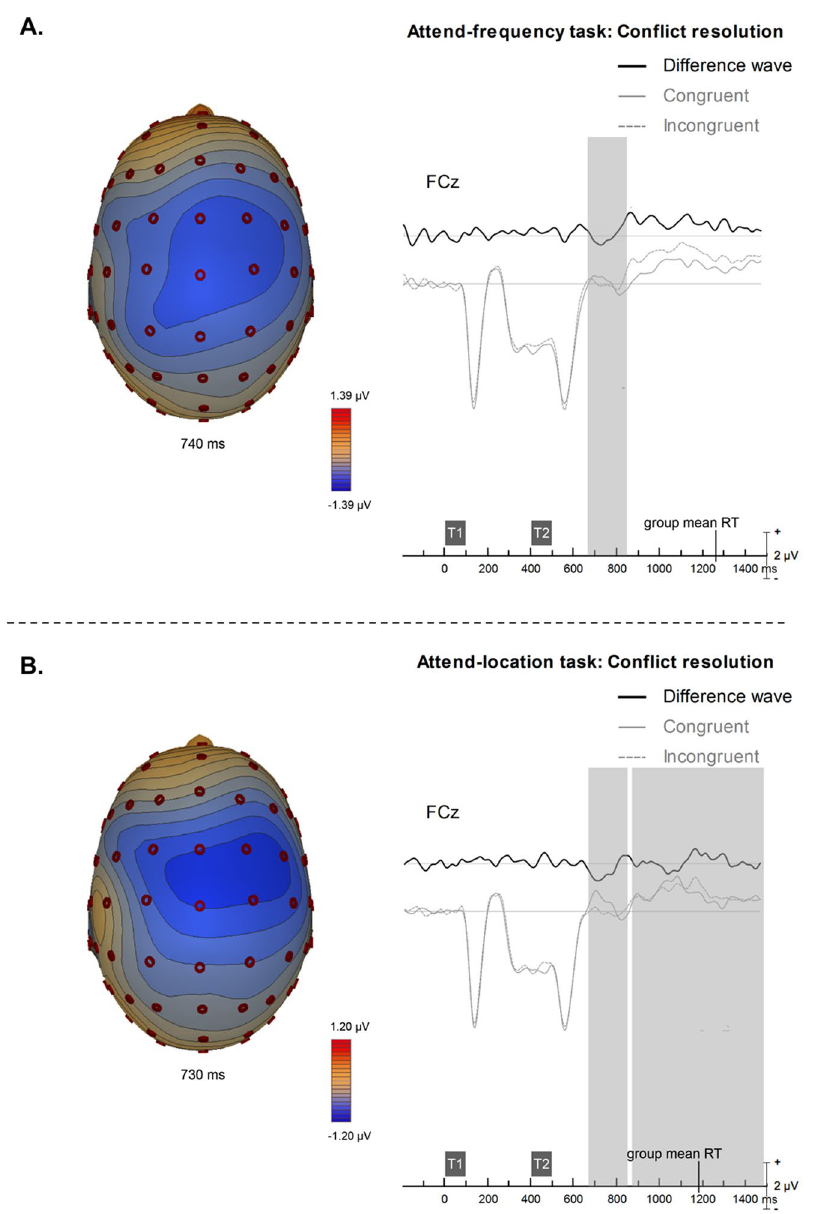
Figure 4. Conflict resolution TAiL effect group mean event-related brain potentials recorded over the central frontal (FCz) scalp region for the ( A ) attend-frequency task and ( B ) attend-location task. T1 = first tone; T2 = second tone. Contour maps illustrate the brain activity at the peak of the difference waves. Shaded areas indicate the time period where the spatio-temporal cluster was significant, p < 0.05. For the attend-frequency task, the spatio-temporal cluster included the following electrodes: FCz, FC2, FC4, Cz, C2, C4, C6, CP2, CP4, CP6, Pz, P2, P4, and P6. For the attend-location, the spatio-temporal cluster included electrodes F4, FC1, FCz, FC2, FC4, FC6, C1, C2, C4, C6, CP2, CP4, CP6, and P4. Group mean RT across trials was 859 ms for the attend- frequency task and 793 ms for the attend-location task, time-locked to the onset of the second